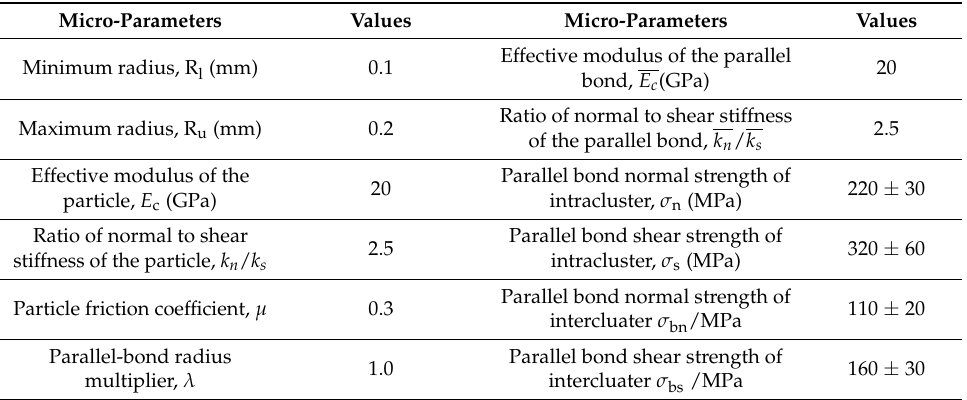
Table 2. Micro-parameters of the cluster model in PFC 2D